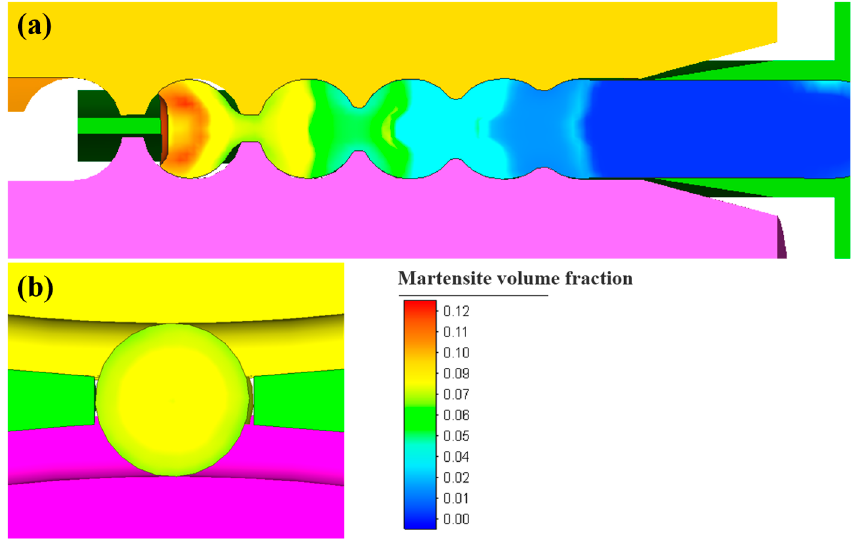
Figure 12. Martensite volume fraction of steel balls during skew rolling process in ( a ) the longitudinal section and ( b ) the transverse section.